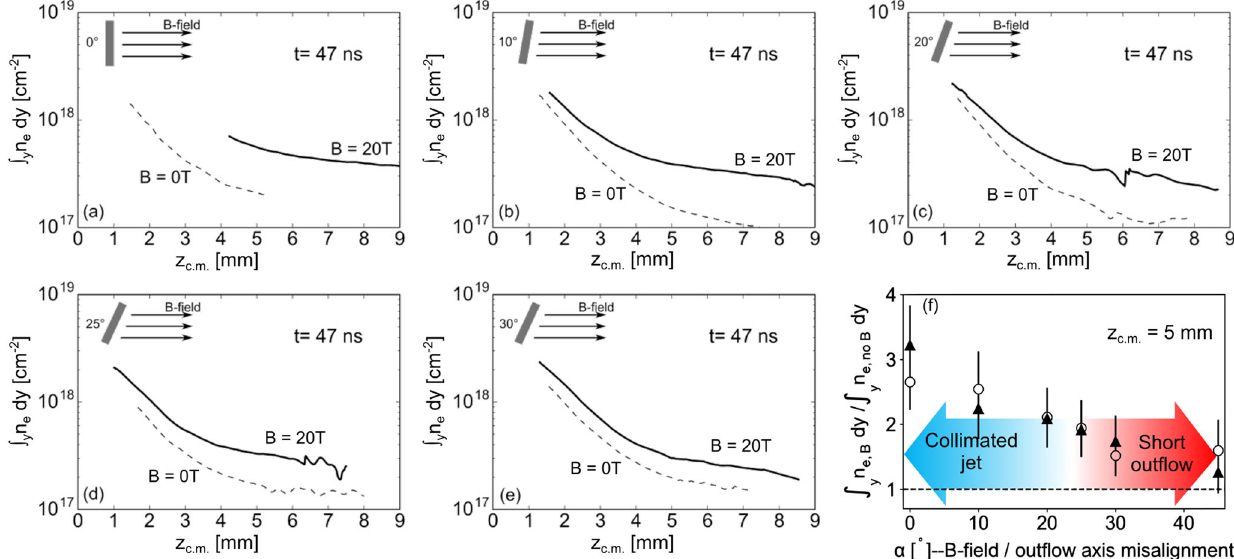
Fig. 4 Evolution of the center of mass electron density vs. magnetic misalignment: evidence for lack of collimation. Line of sight integrated electron density at the location of the center of mass, ∫ y n e dy ( z c.m. )[cm − 2 ] (see text; with z c.m. = 0 being the target surface) for different target angles (going from a to e , from 0 to 30 degrees, respectively) relative to the magnetic fi eld direction, and at a time of 47 ns after the start of the plasma expansion. The solid lines show lineouts of plasma expansion in the presence of the magnetic fi eld, while the dashed lines are lineouts without magnetic fi eld. The pro fi les are voluntarily stopped for small and high z. In the fi rst case, the high electron density is inaccessible to optical probing, or fringes quality is too poor. In the second case, the plasma fl ow is out of the accessible fi eld of view. f Ratio ∫ y n e,B dy / ∫ y n e,noB dy as a function of the magnetic fi eld angle vs. the target normal, taken at z c.m. = 5 mm (which is the last point at which we measure the unmagnetized out fl ow in all cases), and at t = 47 ns. For details on the difference between the full triangles and the empty circles and about the error bars, see Supplementary Note